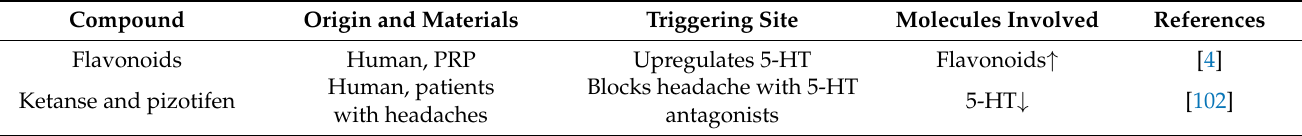
Table 3. Research on the effects of phenols in